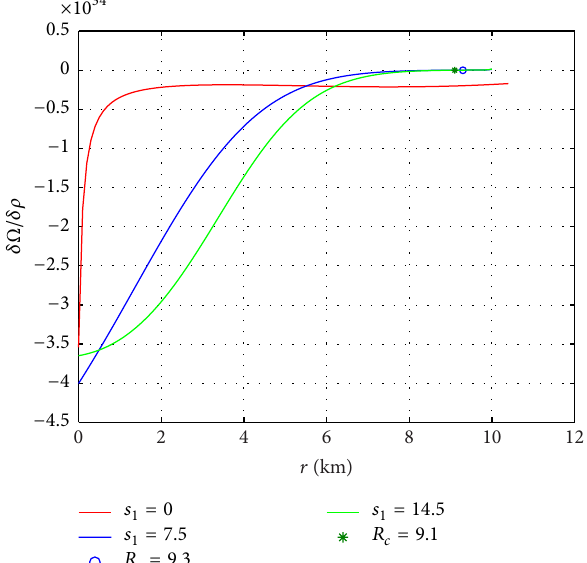
Figure 2: Cracking of PSR J1614-2230 with 𝛾 = 0.0 , 𝛼 = 0.99 , and = 0, 7.5, 14.5 . 𝑠 1